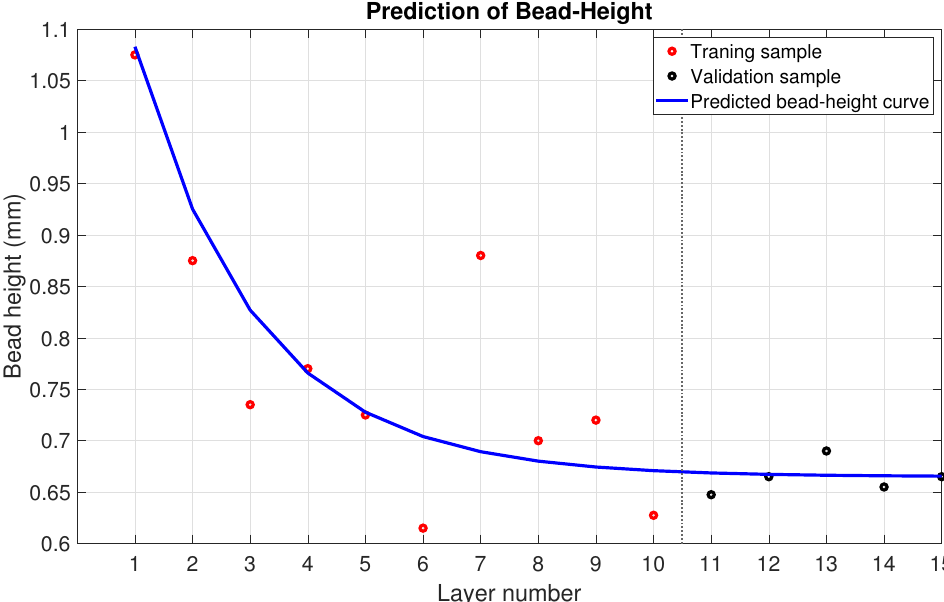
Figure 8. Result of the bead height